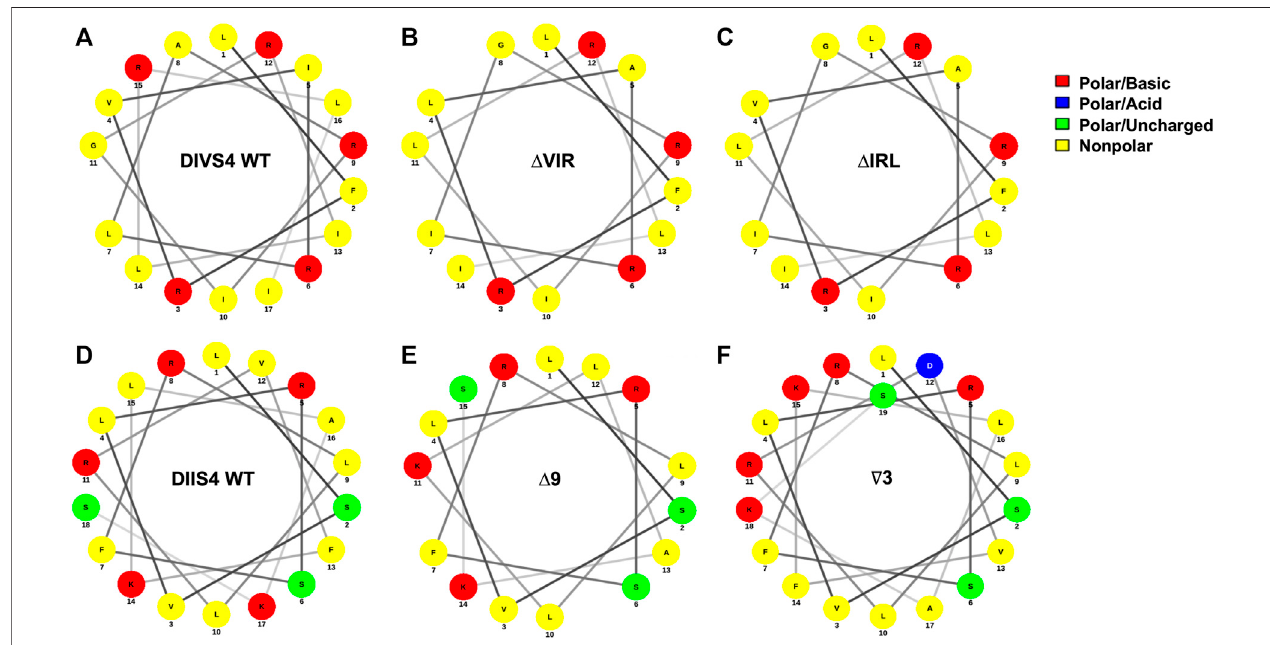
FIGURE 6 | In silico analysis of in-frame deletions in the DIVS4 and DIIS4 transmembrane segments. (A – C) Alpha helix wheel diagrams of the WT DIVS4 transmembrane segment (A) ,the Δ VIRmutation (B) ,andthe Δ IRL mutation (C) . (D – F) Alphahelixwheel diagrams oftheWTDIIS4transmembrane segment (D) ,the Δ 9 mutation (E) , and the ∇ 3 mutation (F) from Inglis et al., 2020. The alpha helix wheel diagrams were generated using NetWheels (http://lbqp.unb.br/NetWheels/).